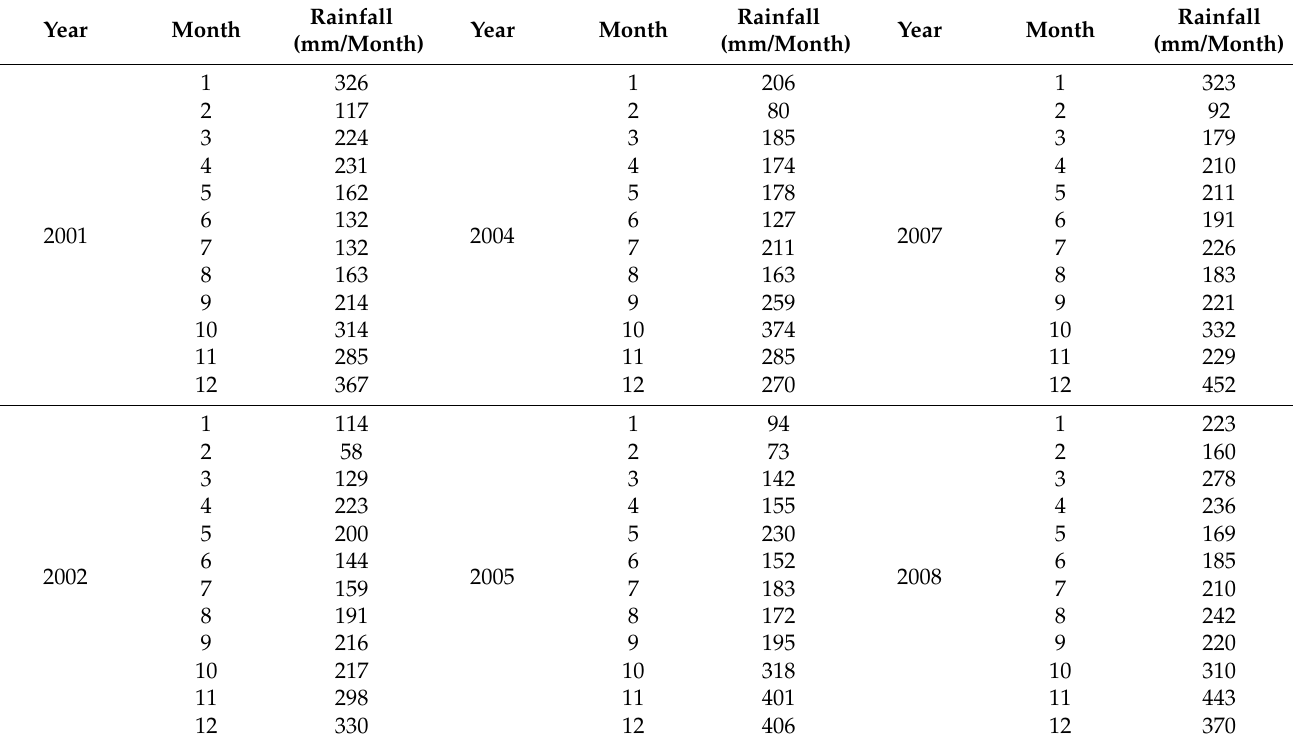
Table A1. Monthly rainfall in Peninsula Malaysia from 2001 to 2009